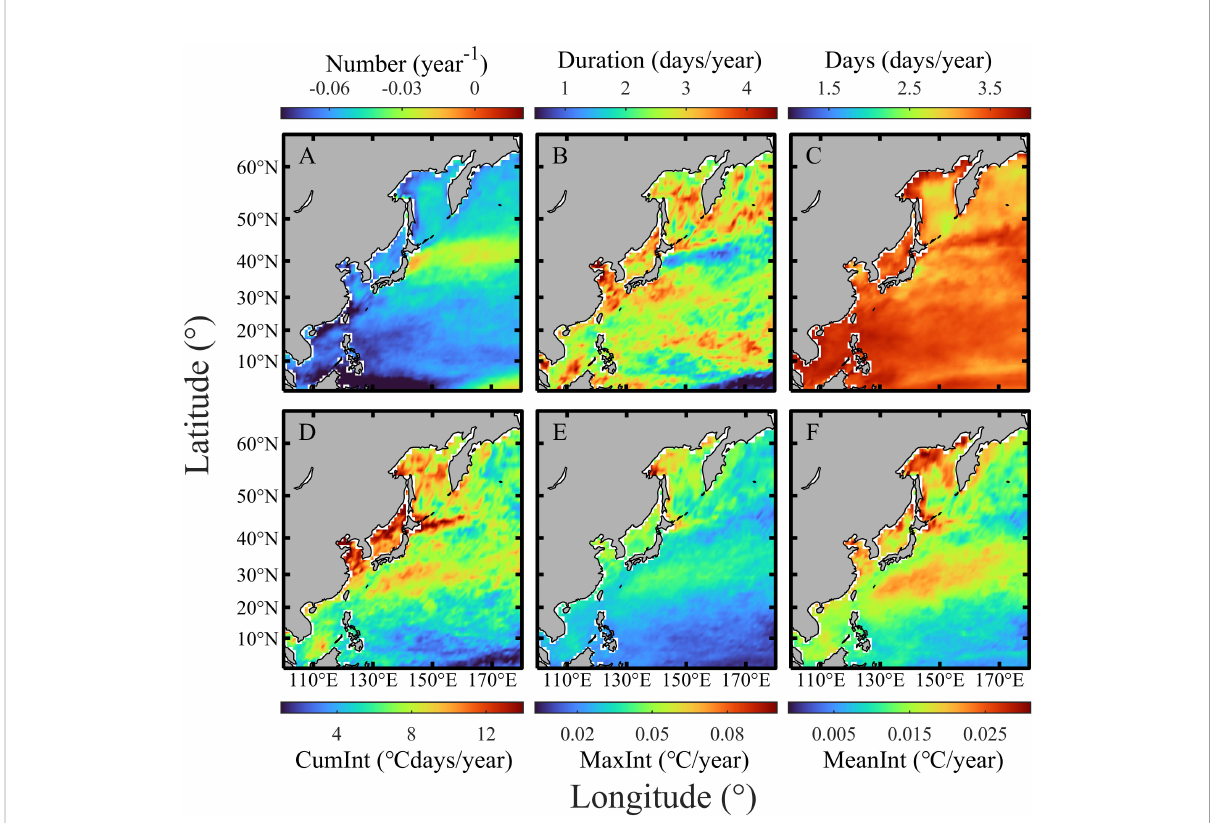
FIGURE 11 Spatial distribution of average annual variation ratio for MHWs characteristics under the SSP5-8.5 scenario. Average of annual variation ratio for MHWs (A) Number (units: year -1 ), (B) Duration (units: day/year), (C) Days (units: day/year), (D) CumInt (units: °Cdays/year), (E) MaxInt (units: °C/ year), and (F) MeanInt (units: